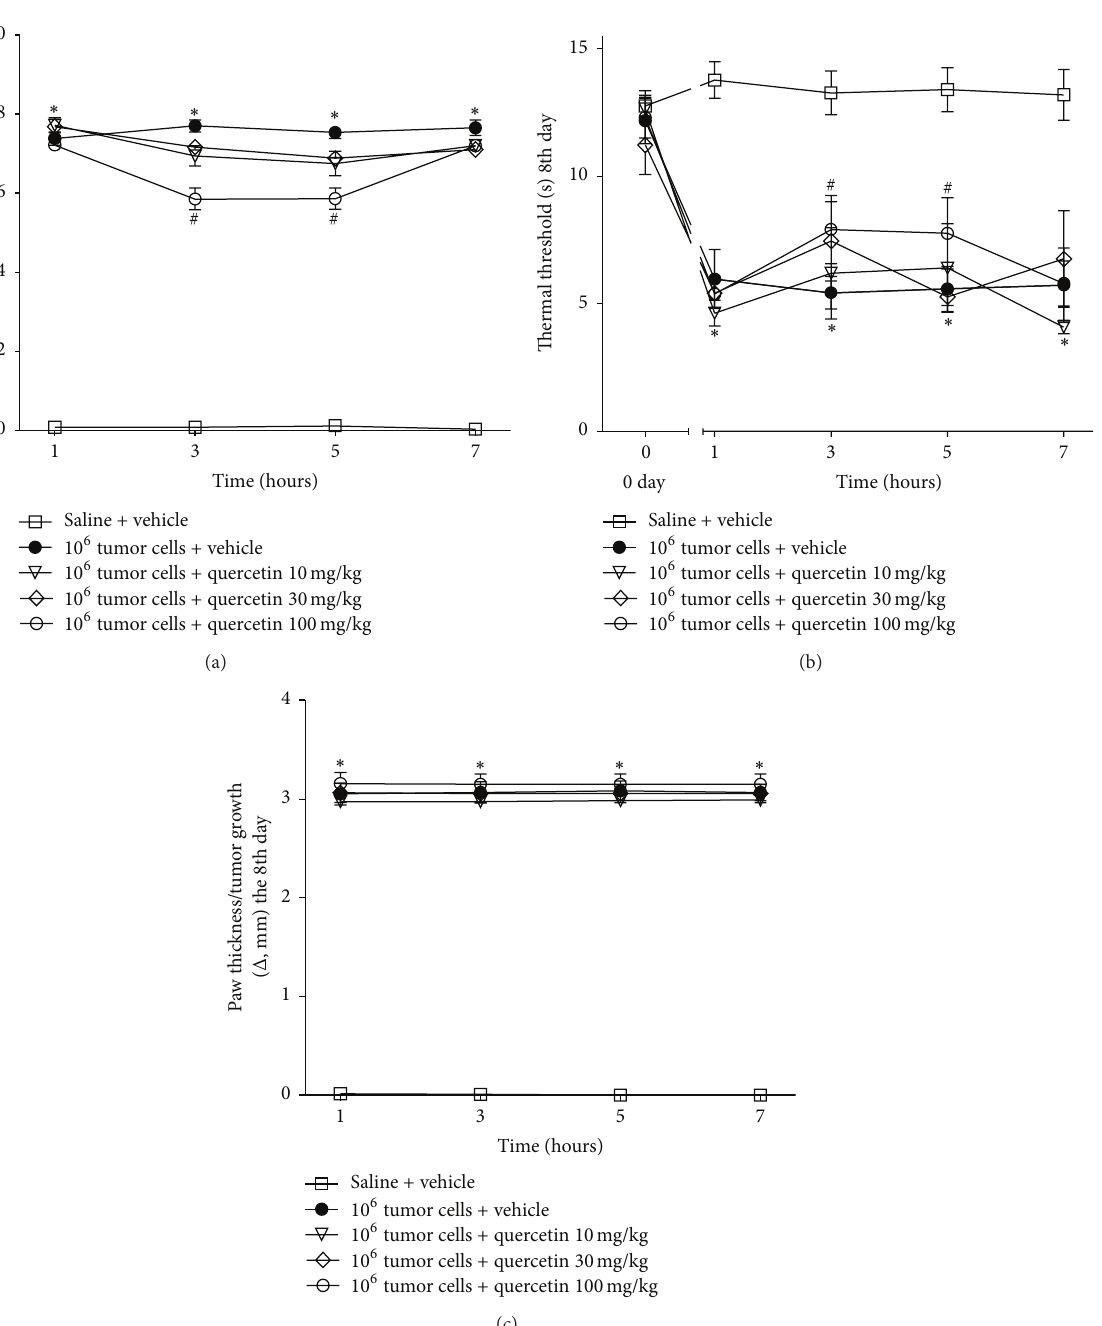
Figure 1: Acute treatment with quercetin inhibits Ehrlich tumor-induced pain-like behavior in mice. Mice received the intraplantar (i.pl.) administration of Ehrlich tumor cells 1 × 10 6 (a–c), and in the 8th day after injection, the tumor cells mice received the acute treatment with quercetin (10, 30, and 100mg/kg i.p.). Mechanical hyperalgesia (a), thermal hyperalgesia (b), and paw thickness (c) were accessed at 1, 3, 5, and 7 hours after the treatment. Data are presented as means ± SEM of six mice per group per experiment and are representative of two separated experiments: ∗ 𝑝 < 0.05 compared to the saline group and # 𝑝 < 0.05 compared to the tumor group. One-way ANOVA followed by Tukey’s